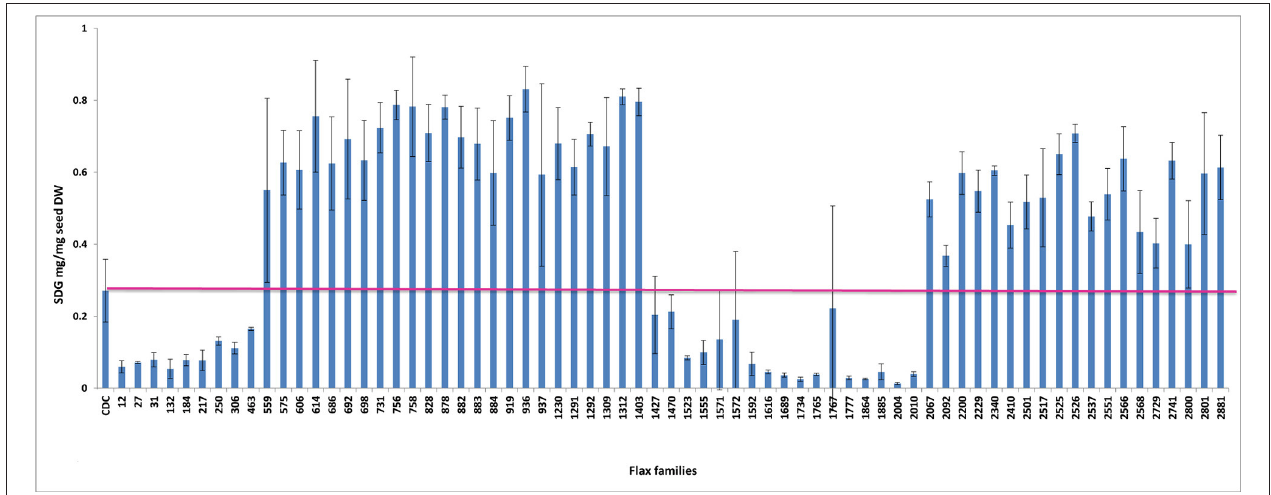
FIGURE 3 | Diversity in the spectrum of SDG production in wild type Bethune (CDC) and 69 EMS mutant lines. The pink line indicates the CDC Bethune threshold line for